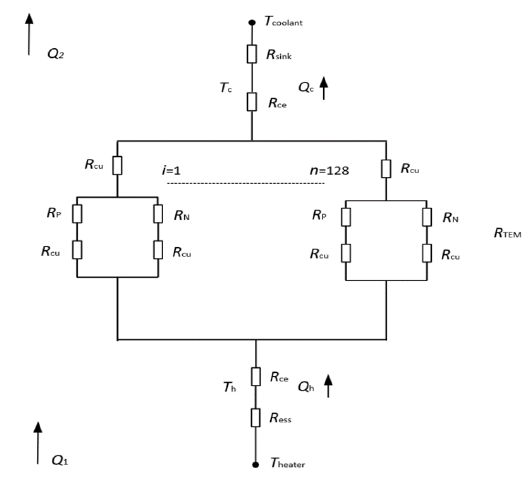
Figure 1. Thermal resistance model of the TEG system.